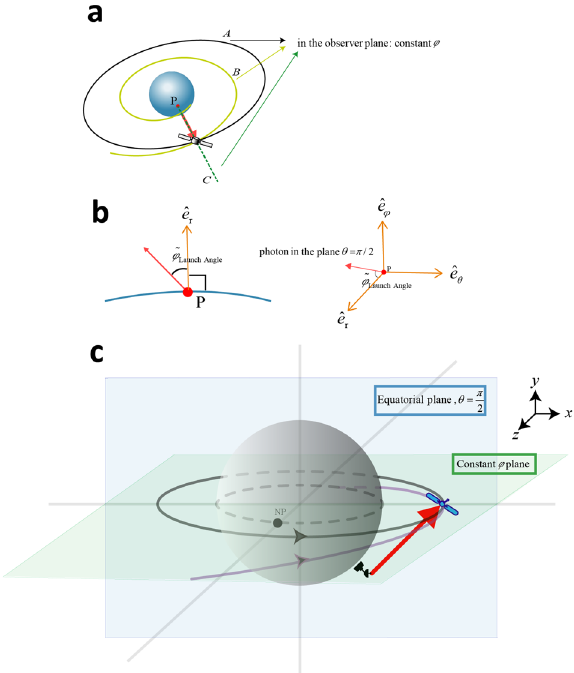
Fig. 2 Schematics of the trajectory of the observer (satellite) and photon. The geodesics of a photon traveling lies in the equatorial plane, θ = π /2 and the observer ’ s geodesics is lying in the constant φ -plane (the point NP on the sphere represents the North Pole). a A, B, and C represent the geodesics of massive free-falling observers radially, in a circular orbit, and spiraling orbit, respectively. b , c The non-radial launching angle of a photon from the surface of the Earth to the satellite in a Fig. 2c circular (gray) and spiraling (purple) orbit in the constant- φ